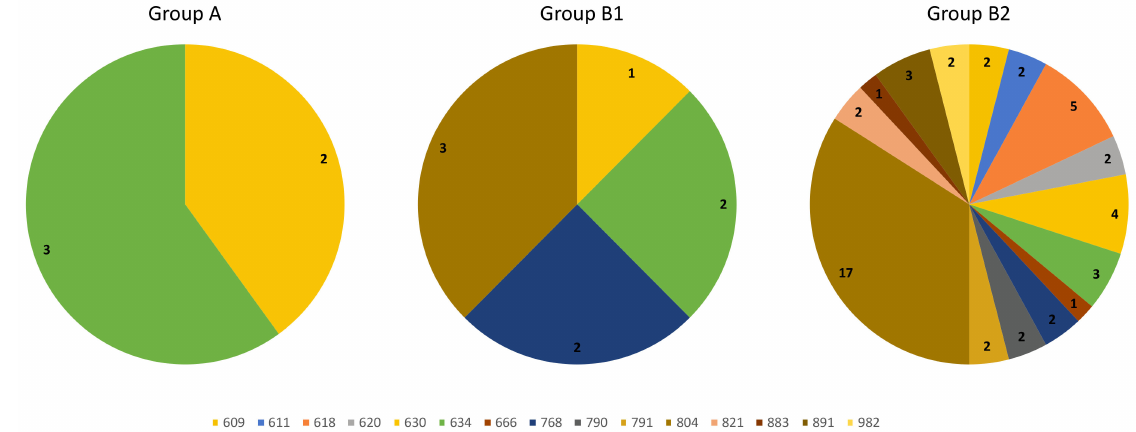
Figure 4. Genetic landscape of subjects younger than 18 years belonging to Group A, B1 or B2.